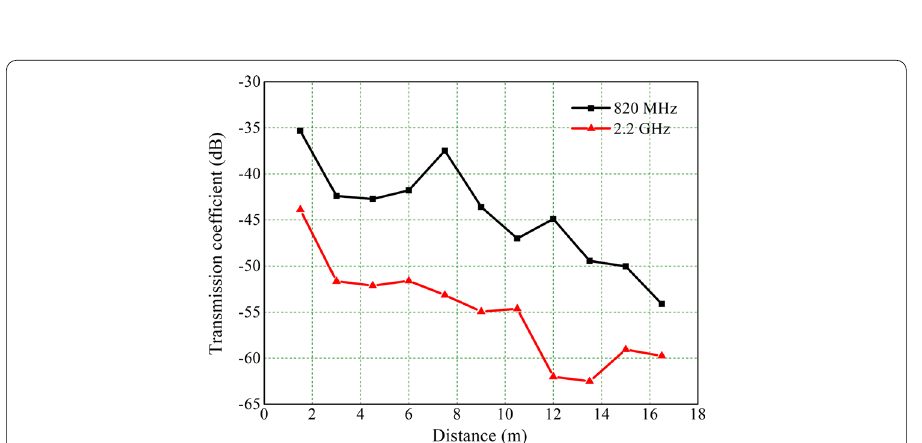
Fig. 17 Transmission coefficients for different operation bands of the automobile antenna in the urban environment. The red line is the 2.2 GHz frequency band, and the black line is the 820 MHz frequency